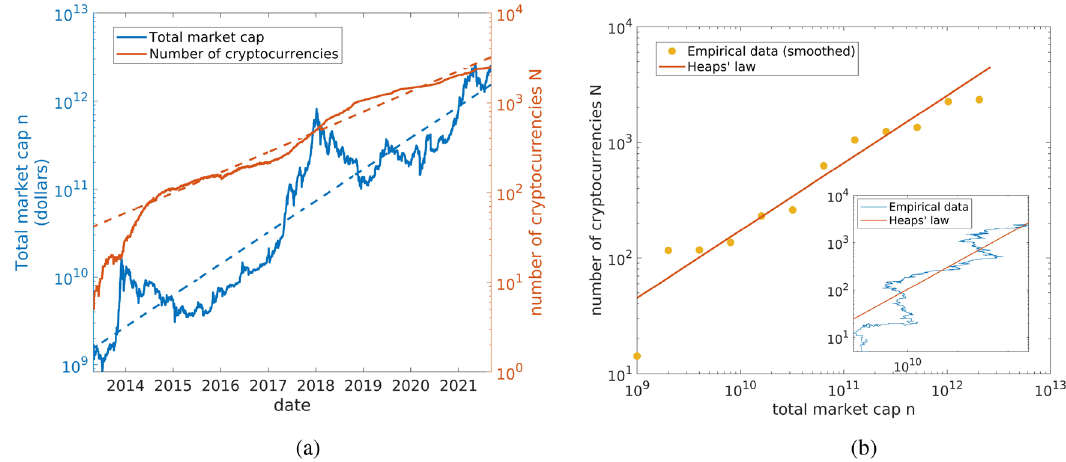
Figure 2. ( a ) Evolution of the number of different coins N and market cap n over time. Growth of the number of coins N (red line) and of the total market cap n (blue line) as function of time. Both quantities have increased at an exponential rate in time since 2013. Dashed lines are guides for the eyes. ( b ) Heaps’ law. Parametric plot of N versus n ; the yellow points have been obtained performing an average with exponentially increasing window. The number of coins grows as a sublinear power-law of the total market cap, indicating the presence of Heaps’ law in the market cap. Red line shows the theoretical Heaps’ law computed from Zipf’s exponent. We also reported in the inset the raw empirical data without averaging. Figures created with Matlab R2021a https:// it. mathw orks. com/ produ cts/ matlab.